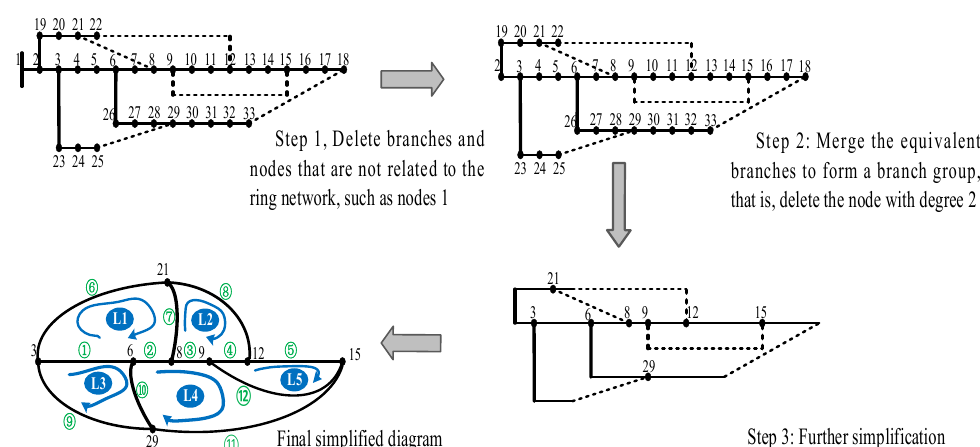
Figure 2. Simplified diagram of distribution network.